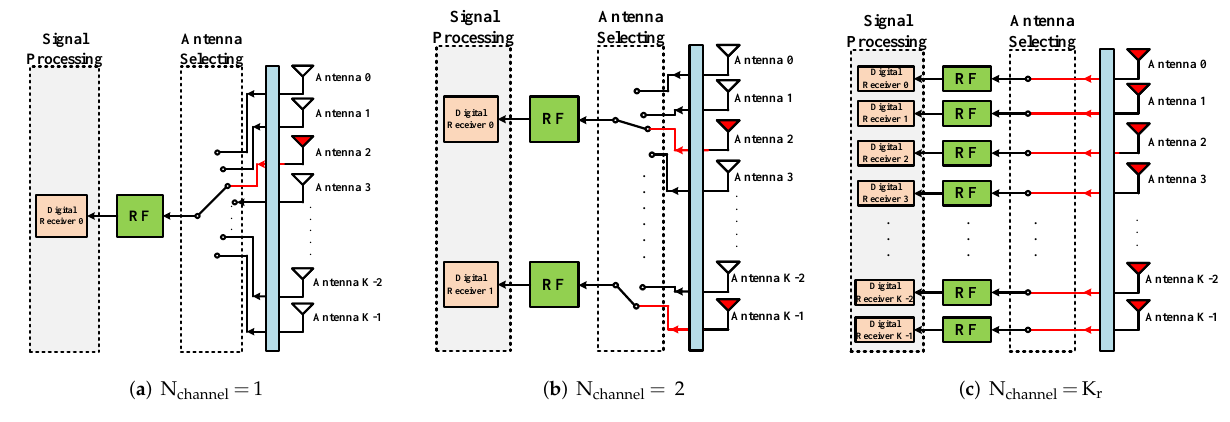
Figure 5. Multi-channel